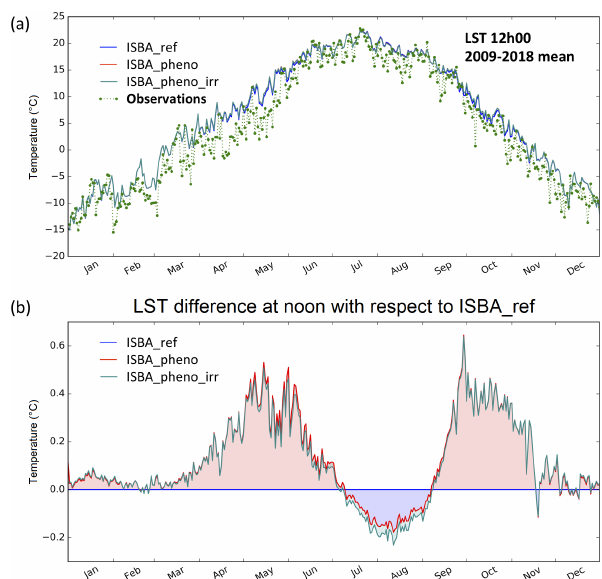
Figure 8. Seasonal variation in surface temperature daily values at 12:00 local solar time ( ◦ C) in the most densely irrigated part of Nebraska (Fig. 2e) from 2009 to 2018 (a) , as derived from the reference simulation ISBA_ref (blue line), ISBA_pheno (red line), ISBA_pheno_irr (cyan), and the CGLS product (green dotted line). The surface temperature differences at 12:00 local solar time (b) of ISBA_pheno_irr and ISBA_pheno simulations with respect to the ISBA_ref simulations are